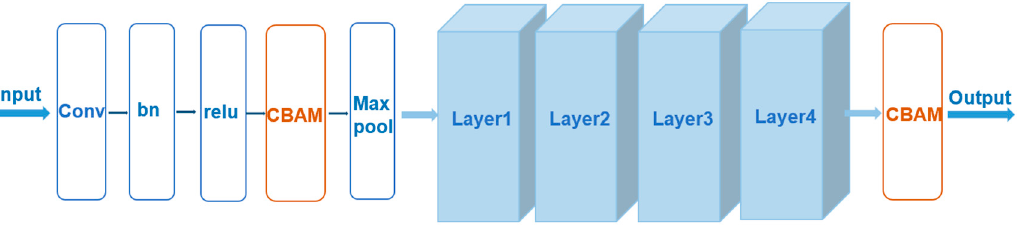
Figure 2. Structure diagram of ResNet50-CBAM.